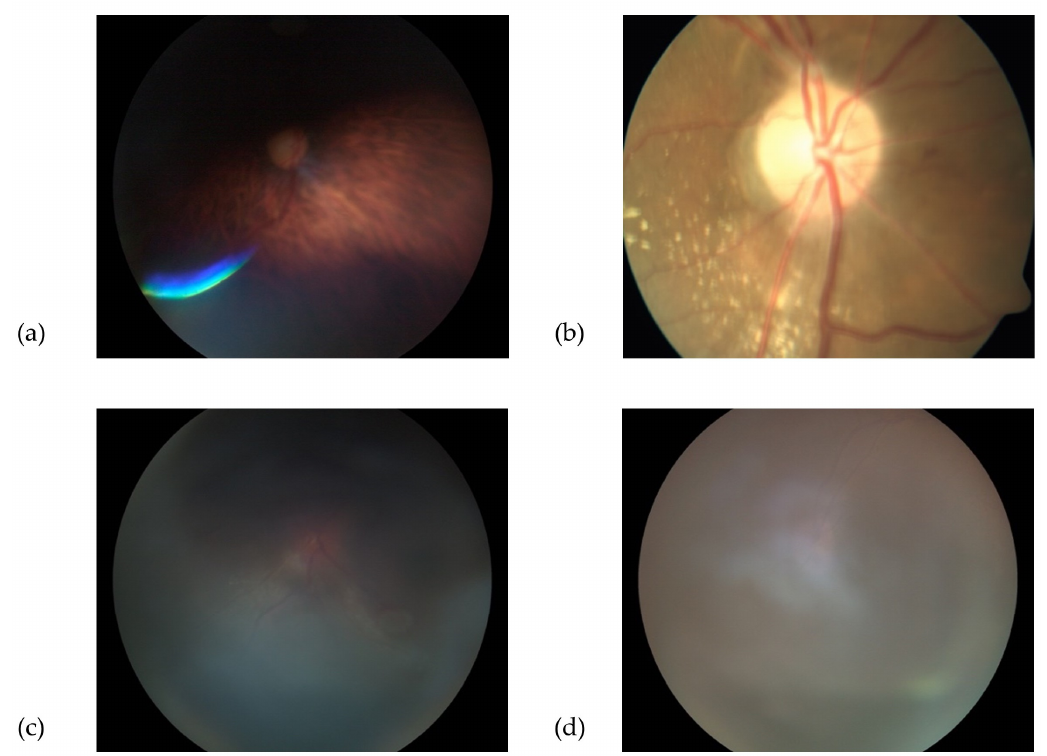
Figure 3. Examples of “poor” quality fundus images; the optic disc is partially masked ( a ), associated with other retinal lesions ( b ) and totally masked ( c , d ).